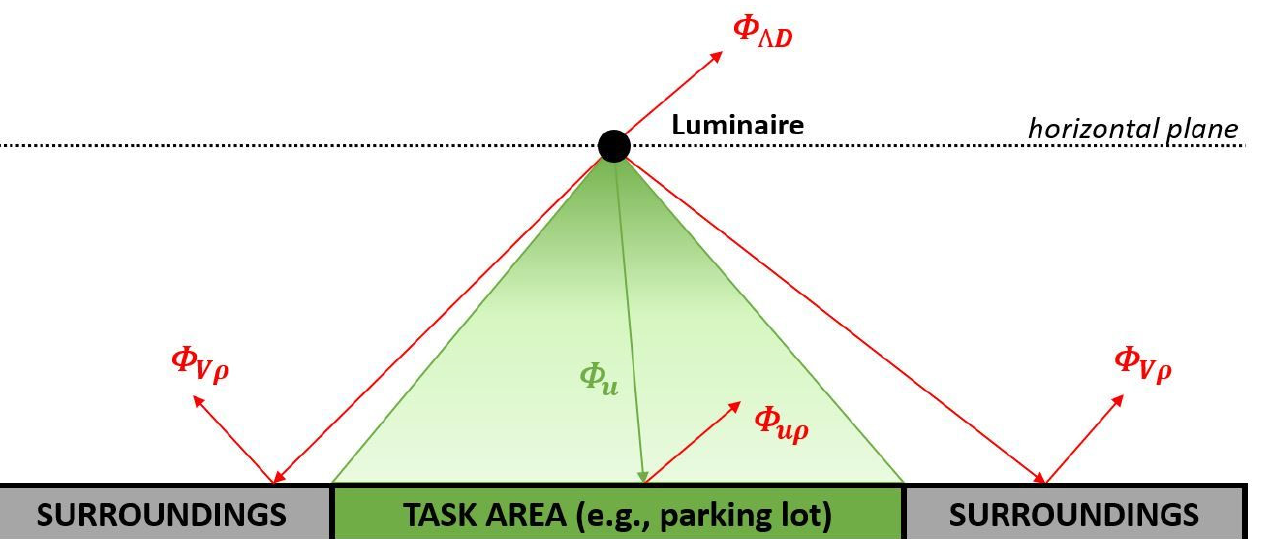
𝜙 (cid:3048) — useful luminous fl ux, (cid:3023)(cid:3096) — luminous fl ux re fl ected from